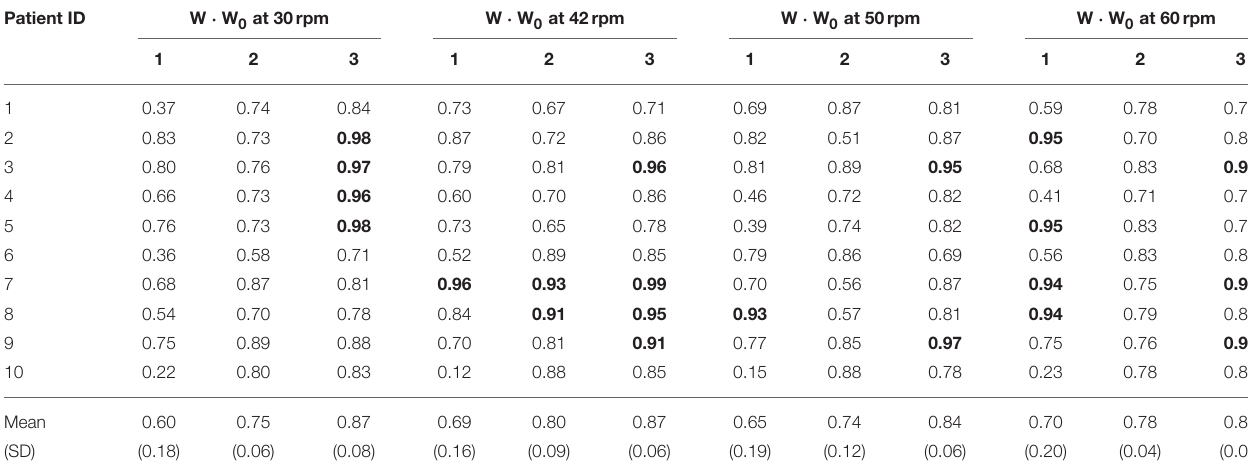
TABLE 4 | Normalized scalar product between matching muscle synergy vectors from matrices W of each patient and the matrix W 0 obtained from all healthy subjects pooled together, considering the set of 8 muscles. Patient ID W · W 0 at